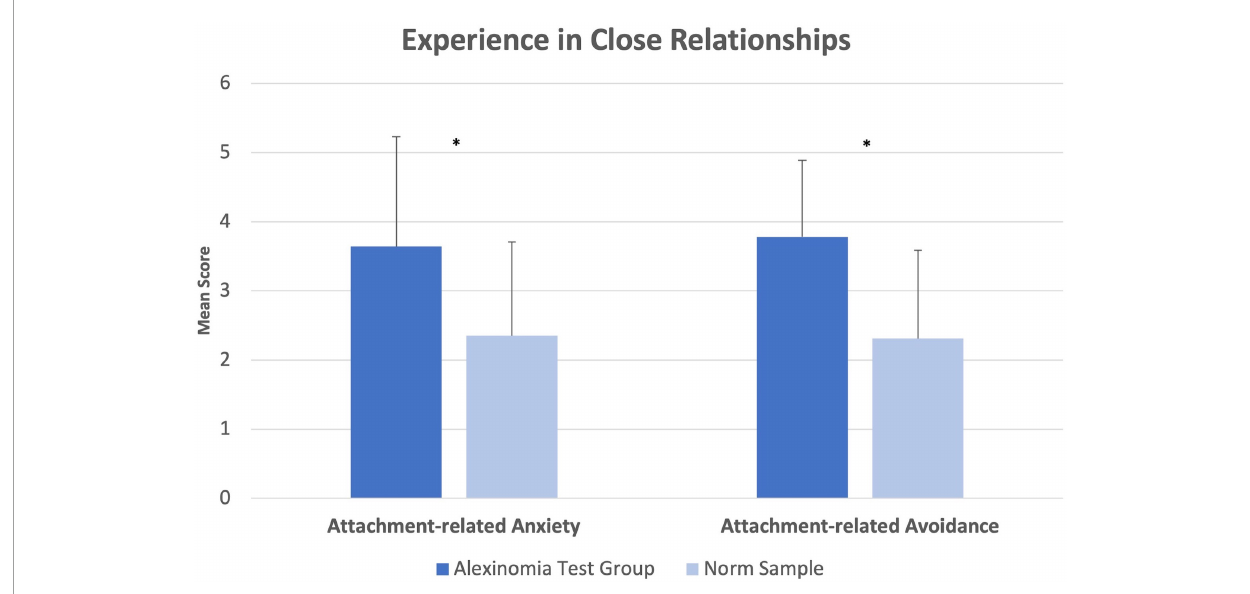
FIGURE4 Experience in Close Relationships (ECR-RD12). Comparisons of group means in the ECR-RD12. Error bars indicate 1 SD. ∗ p < 0.05.